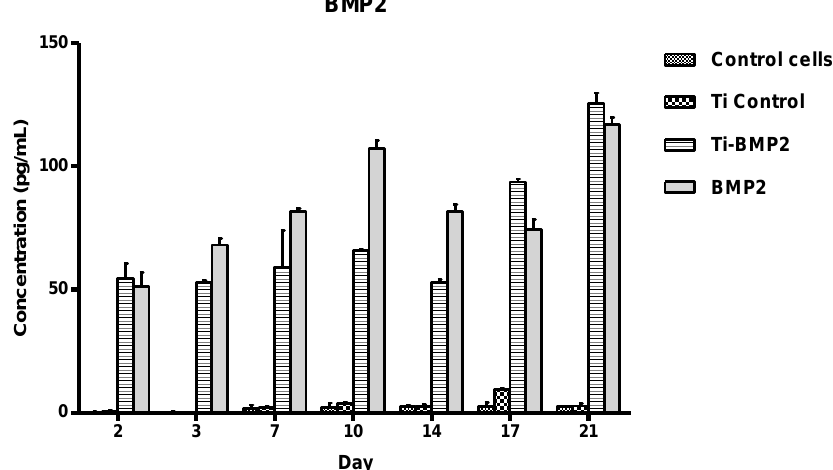
Figure 5. BMP2 concentrations at different time intervals in the culture medium samples from the wells with and without titanium implants. Legend: Control cells: cells seeded in wells containing only culture medium; Ti Control: uncoated titanium implants; Ti-BMP2: titanium implants coated with chitosan film containing microcapsules loaded with BMP2; BMP2: culture medium with added BMP2, without titanium implants.